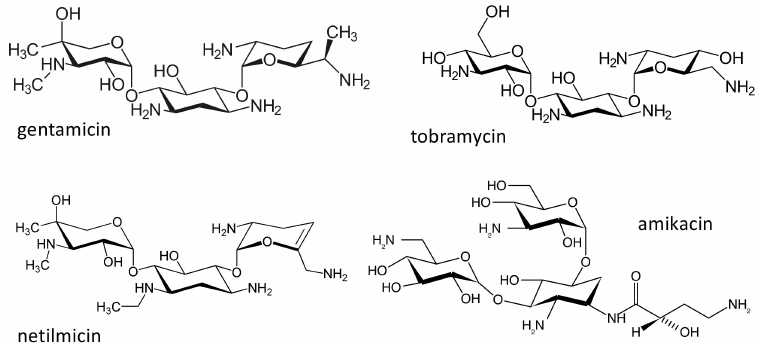
Figure 6. Chemical structure of the aminoglycosides gentamicin, tobramycin, netilmicin and